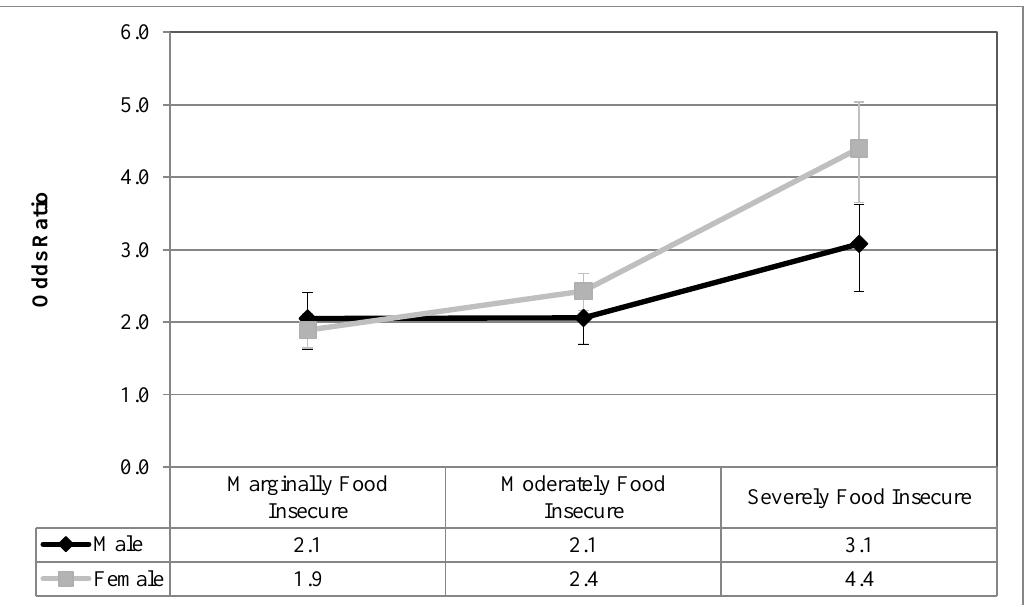
Figure 1. Odds ratio of reporting depressive thoughts in the past month for each level of household food insecurity stratified by sex, compared with food secure; results from reduced binary logistic regression.